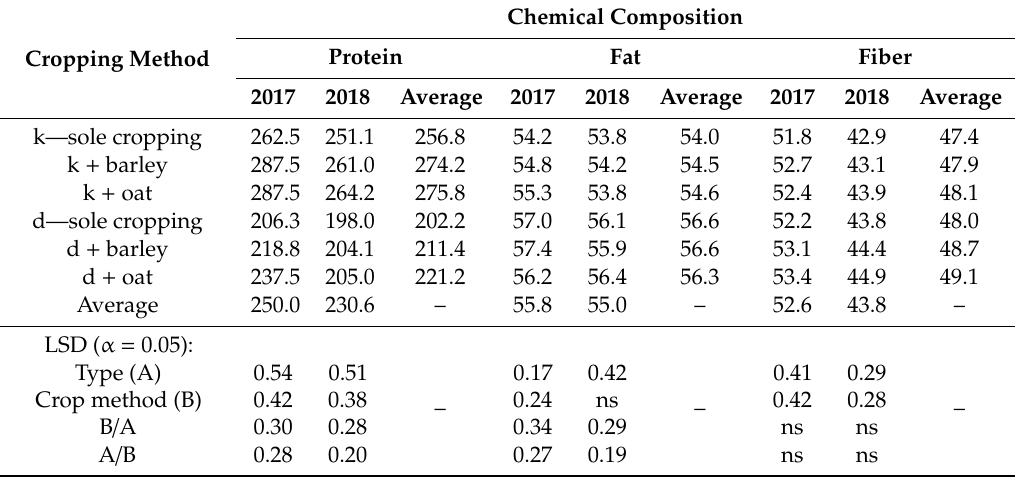
Table 7. Total protein, crude fiber and fat content (g · kg − 1 ) in chickpea seeds, depending